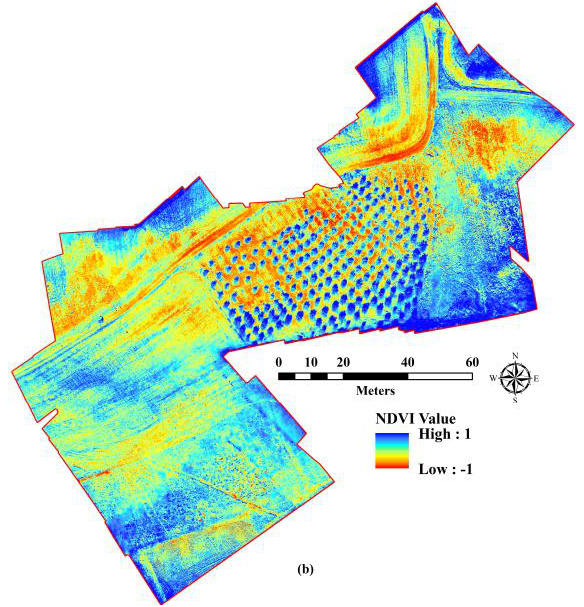
Figure 6. Positional distribution of location control